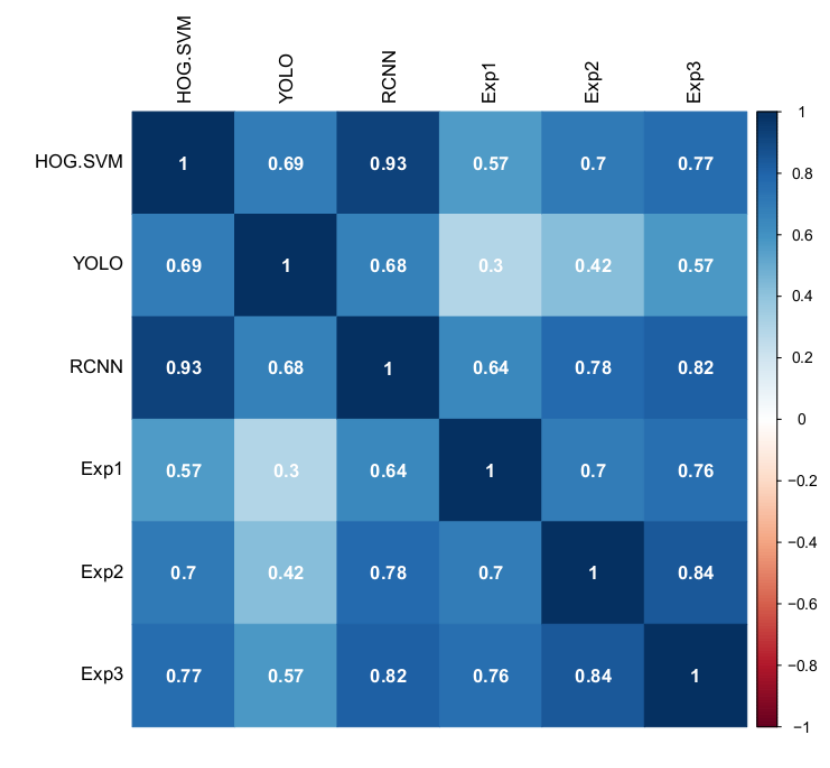
Figure 8. ( a ) Weed coverage probability distribution according to each established method (machine and expert methods). ( b ) Box plot for each method. Note that experts have greater variability in their methods than machine methods. Meanwhile, machine methods have lesser variability among themselves. ( c ) Correlation matrix with expert and machine learning methods. Values between machine learning methods are higher than the rest of the matrix. However, expert 3 achieved the closest values to each artificial approach. Notice that YOLO architecture obtained smaller correlation values with R-CNN and SVM. This was because YOLO did not get contours in each detection like SVM and R-CNN methods do.